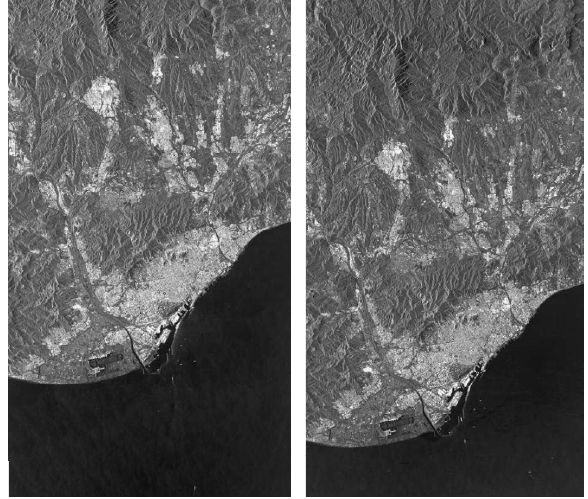
Figure 2. TSX StripMap mode image-pair (left: image 1, right: image 2)